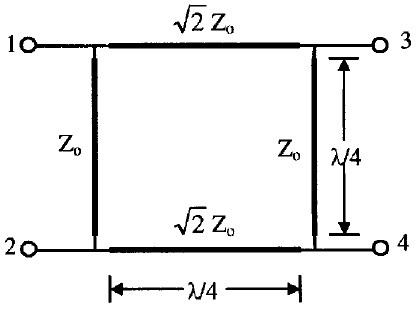
FIGURE 8 Branch-line